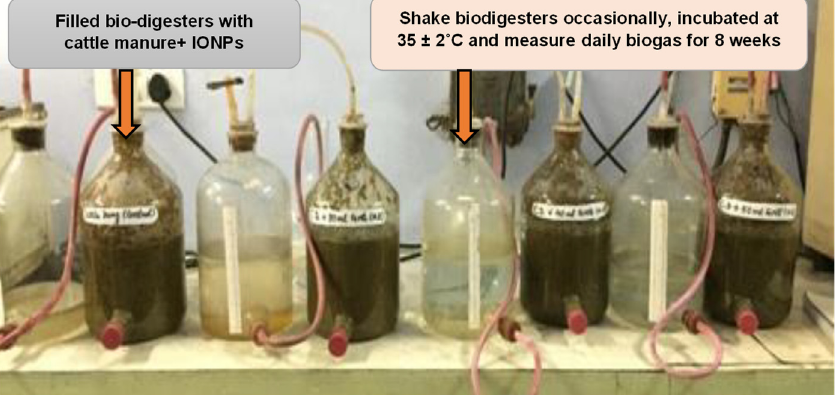
Figure 1. Schematic diagram of a laboratory-scale biodigester experimental setup for biogas production.